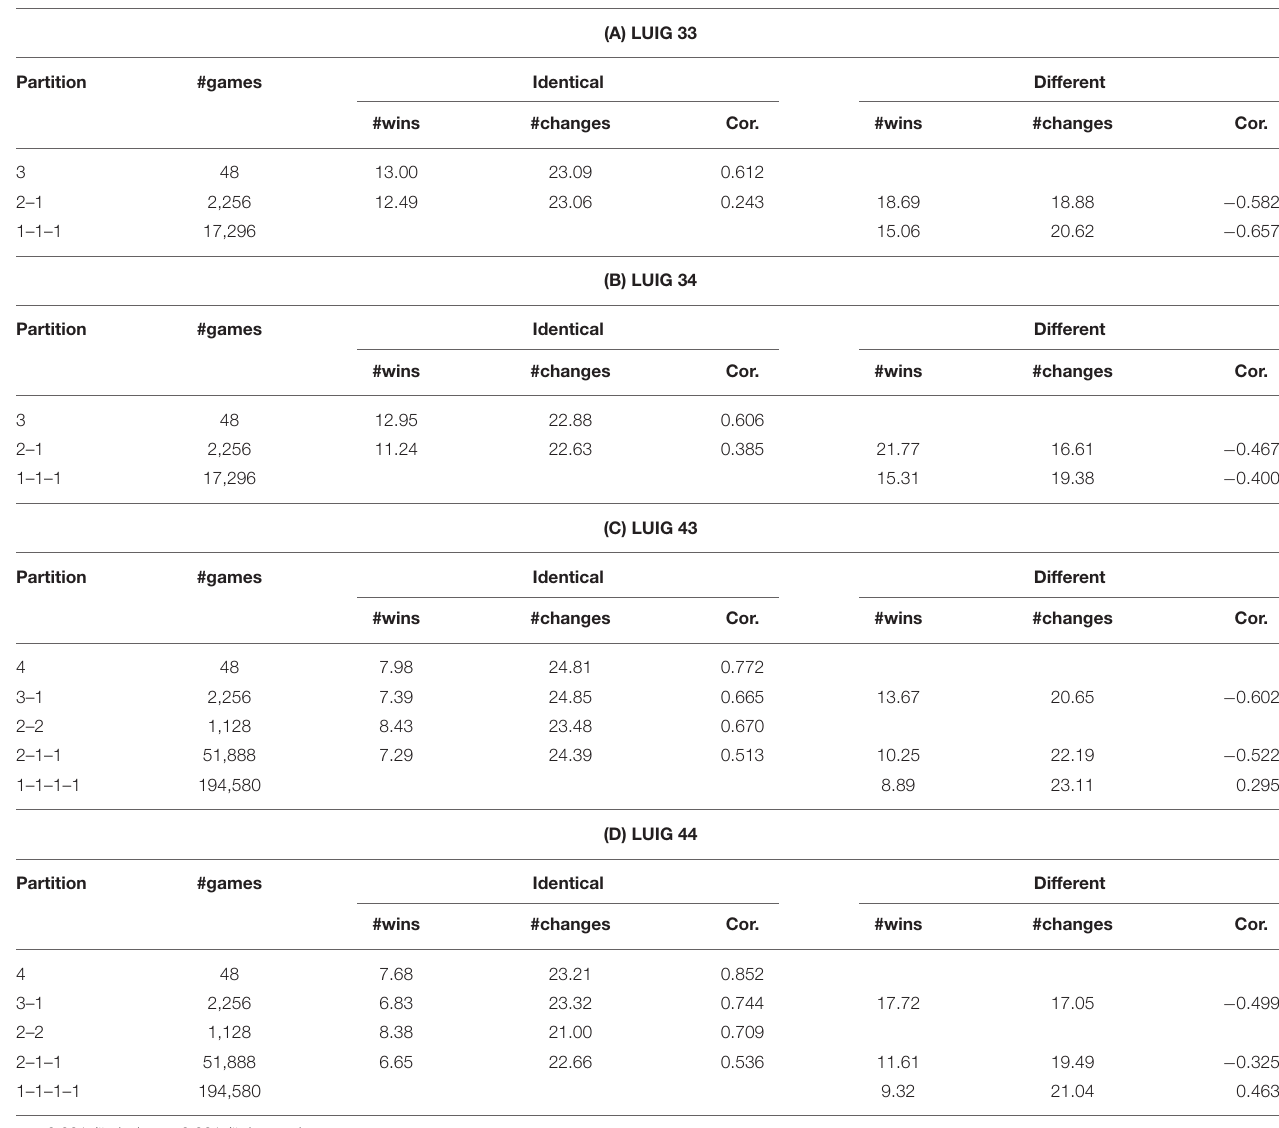
TABLE 4 | Differences of performance with respect to the constitution of players ( p -values are from Wilcoxon signed rank test).